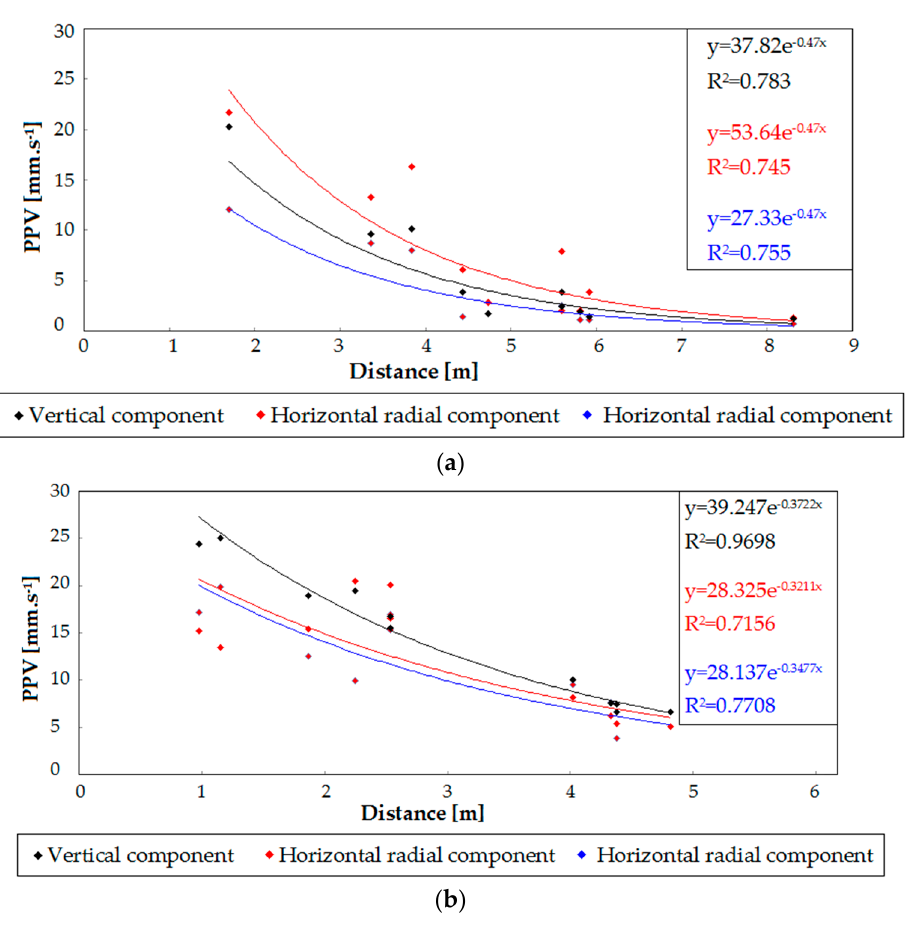
Figure 12. Attenuation curves for the given environment acquired pursuant to in situ measurements—( a ) first and ( b ) second stages of compaction.